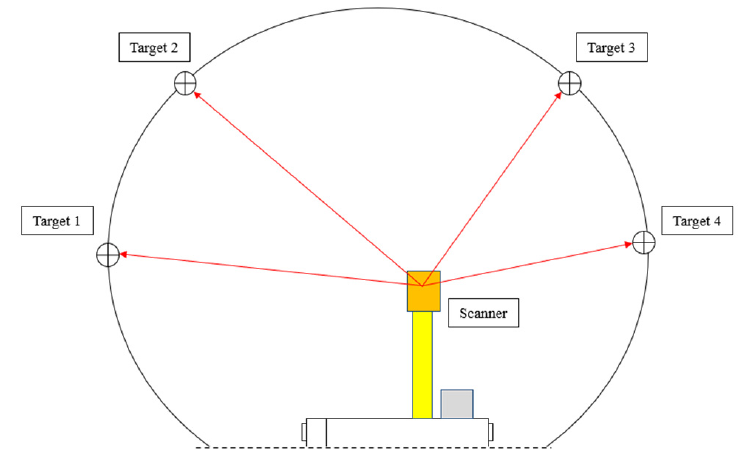
Figure 10. Scanner Calibration.